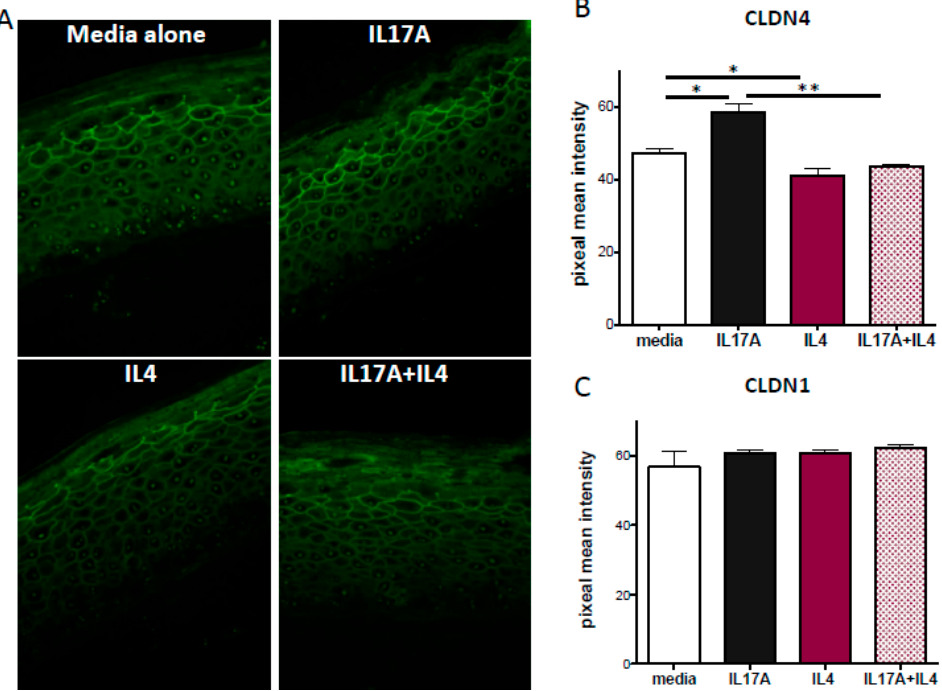
Figure 4. IL-17A increases CLDN4, but not CLDN1 in an organotypic skin model. IL-17A (100 ng / mL), IL-4 (50 ng / mL) or a combination of the two were added to the media of organotypic cultures for 72 h after 9 days of growth. ( A ) Paraffin-fixed sections were stained with either a CLDN4 (pAb) or CLDN1 (JAY.8; not shown) antibody and detected with an Alexa Fluor 488-conjugated secondary (green). ( B ) CLDN4 and ( C ) CLDN1 immunostaining intensity analysis. Images were acquired at the same instrumental setting and at 40 × magnification. Mean pixel intensity (5 random fields) was measured using ImageJ. All data are shown as mean ± SEM. * p ≤ 0.05, ** p ≤ 0.01.